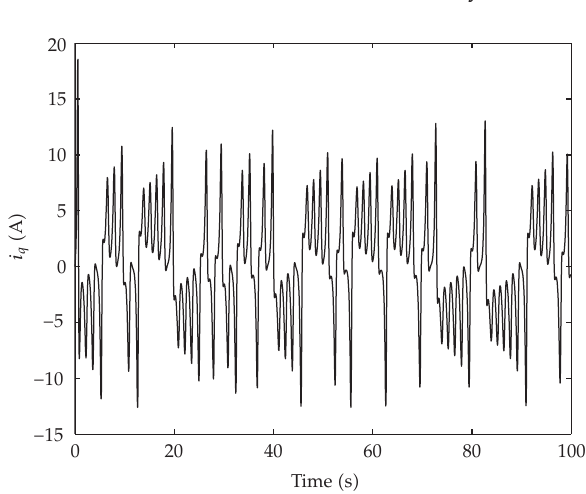
Figure 4: The i q curve of the chaotic PMSM drive system without u d .